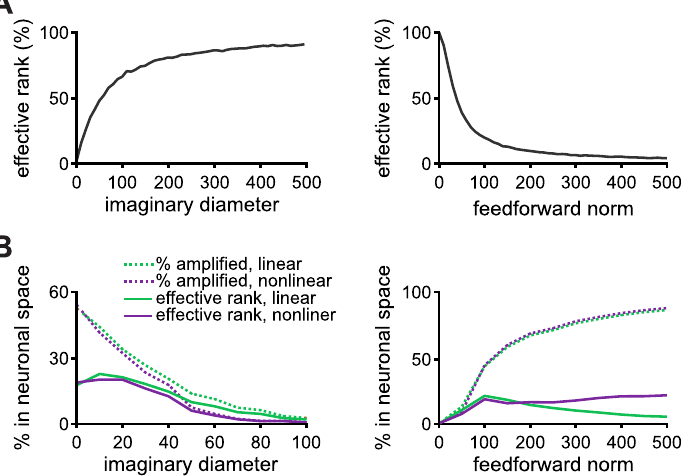
Fig 4. Geometry of output trajectories. A , The effective rank of the eigenvector matrix V of f W as a function of the imaginary diameter (left) and the feedforward norm (right). B , Amplified directions and effective rank of the matrix P (see text) in the linear and nonlinear cases as a function of the imaginary diameter (left) and the feedforward norm (right). The feedforward structure is random from a uniform distribution, and the real distribution is uniform on ( − 0.5, 0.5). In all cases the network size is N = 200. The feedforward Frobenius norm is fixed at 75 for the plots with varying imaginary diameter. The imaginary diameter is fixed at 20 for the plots with varying feedforward norm.